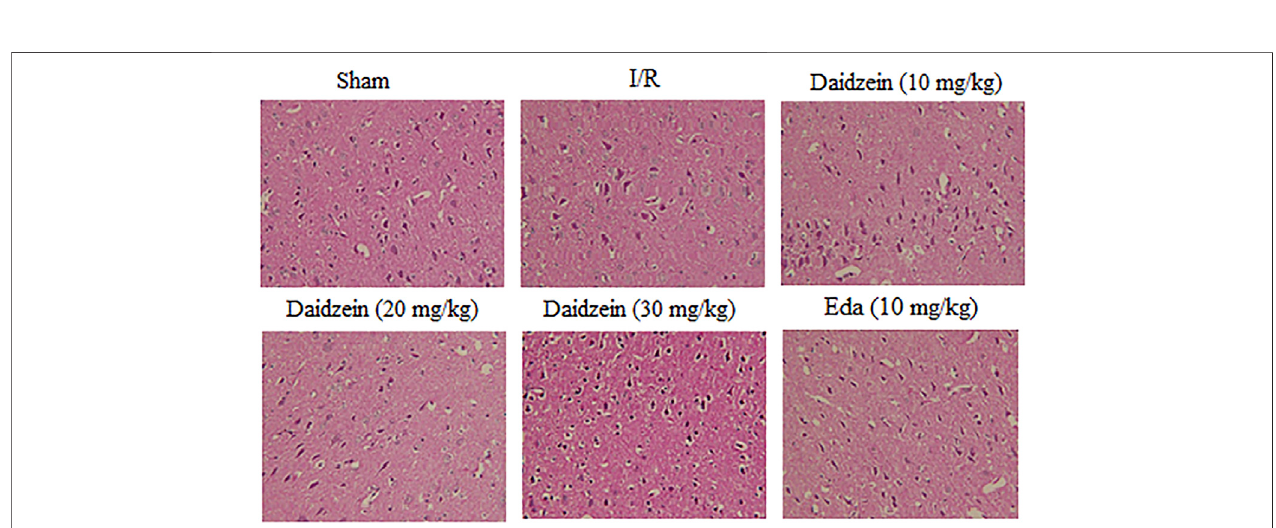
FIGURE4| HEstainingofdaidzeineffectupontheischemicdamageafterI/R. (A) Sham (B) I/R (C) I/R+daidzein(40 mg/kg) (D) I/R+daidzein(80 mg/kg) (E) I/R+ daidzein (160 mg/kg) (F) I/R + Eda (10 mg/kg).